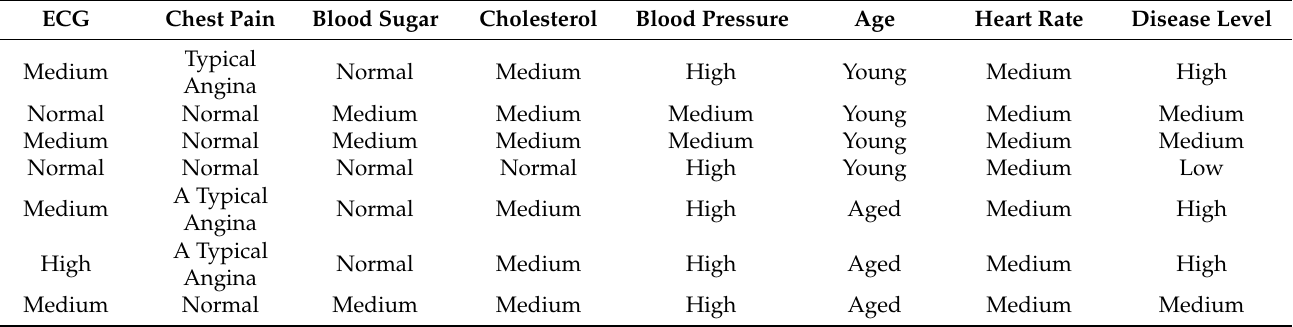
Table 1. The fuzzy input/output